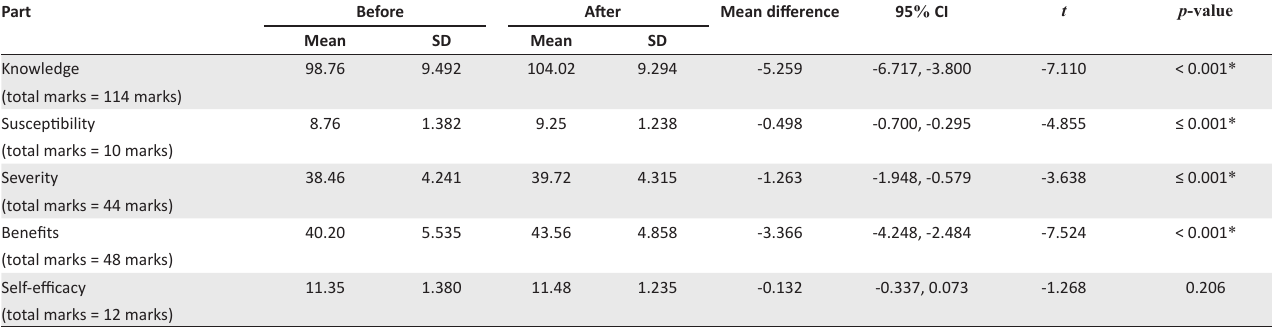
TABLE 3: The pre-post comparison of the flood-risk reduction knowledge level and health belief model component at baseline and after a month of knowledge transfer intervention ( N = 205). Part Before A fter